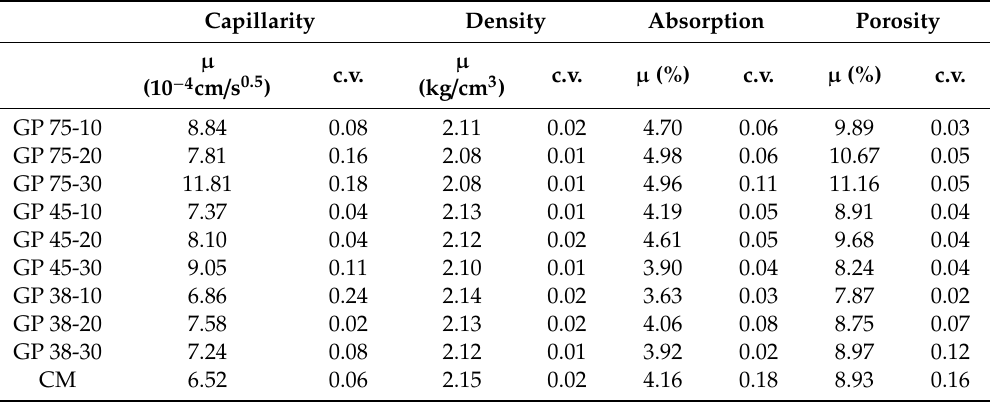
Table 4. Variation coe ffi cients and mean values of durability properties at 28